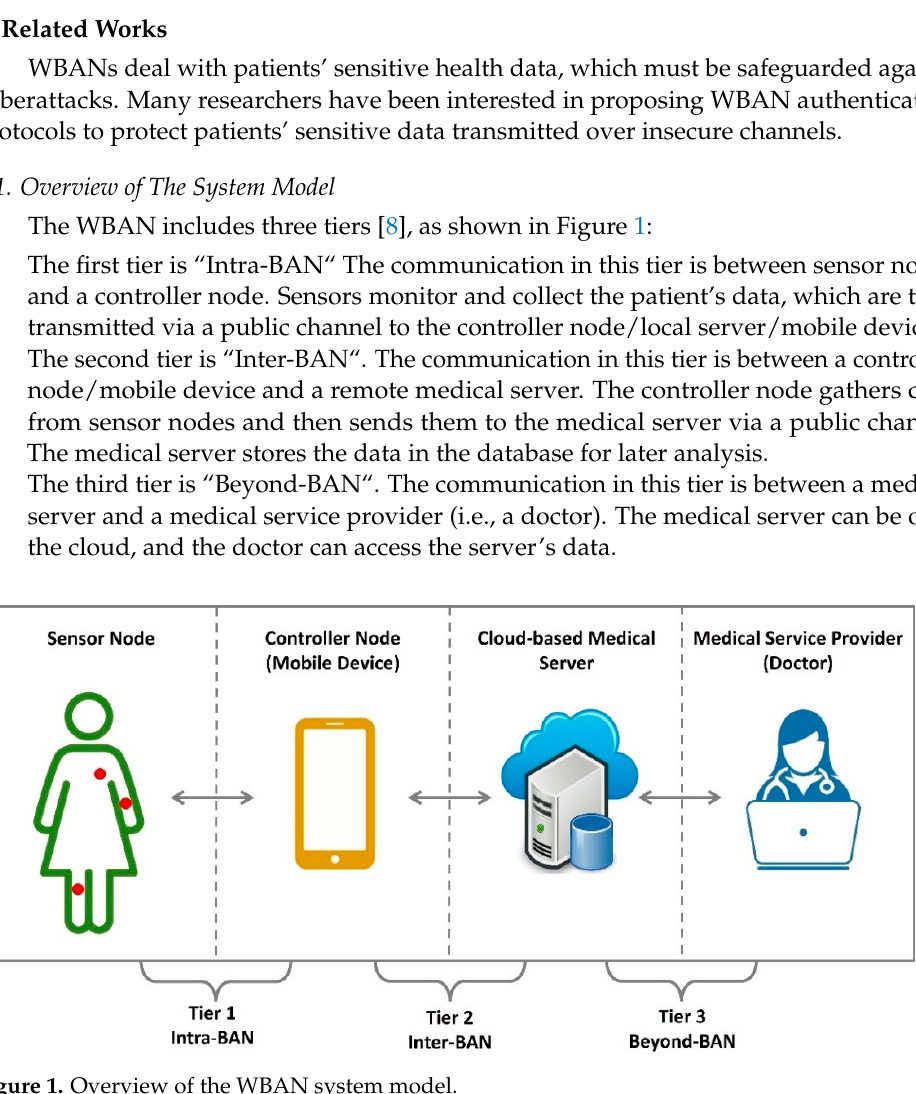
Figure 1. Overview of the WBAN system model.